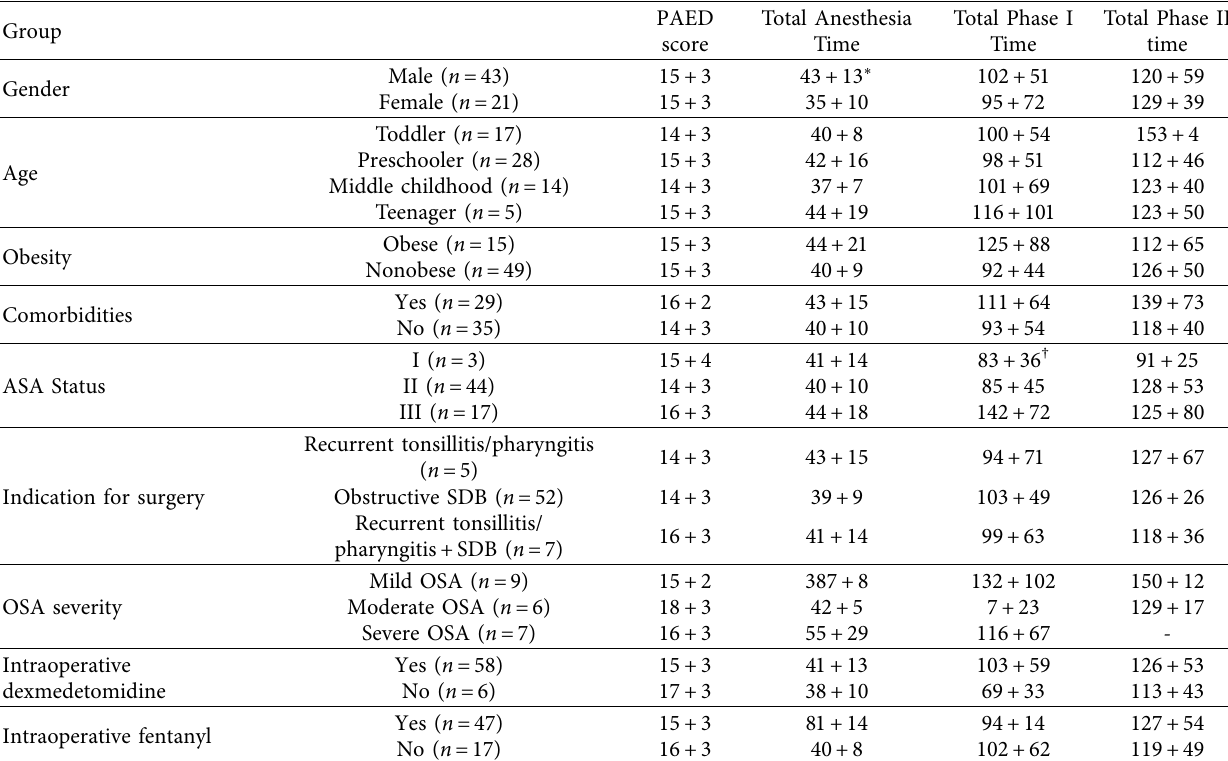
Table 2: Comparison of studied variables in children with emergence